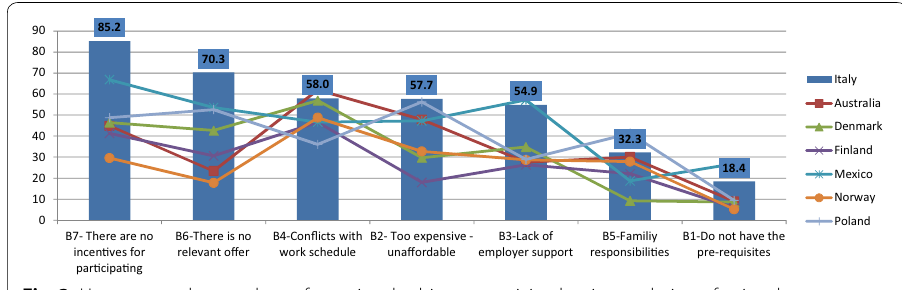
Fig. 3 Upper secondary teachers of vocational subjects perceiving barriers to their professional development, 2013 (%). Source: Author’s calculations based on OECD, TALIS